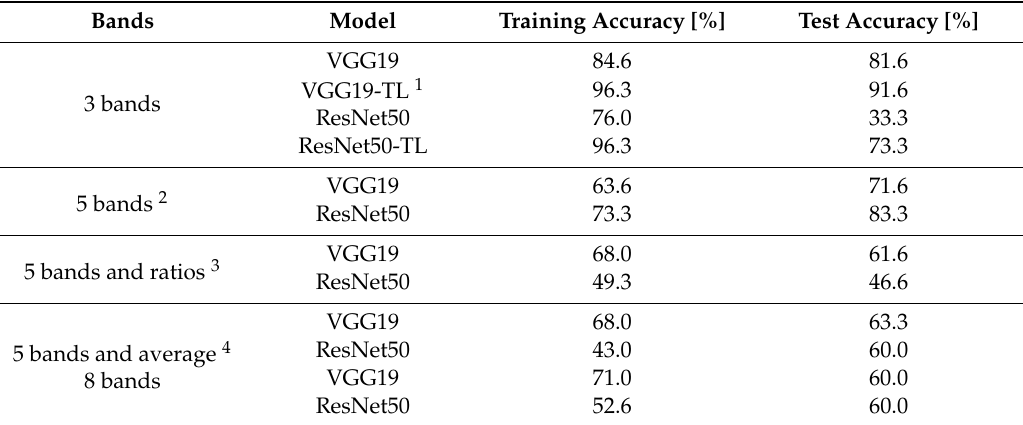
Table 2. Results of identification according to the number of bands and models. Bands Model Training Accuracy [%] Test Accuracy